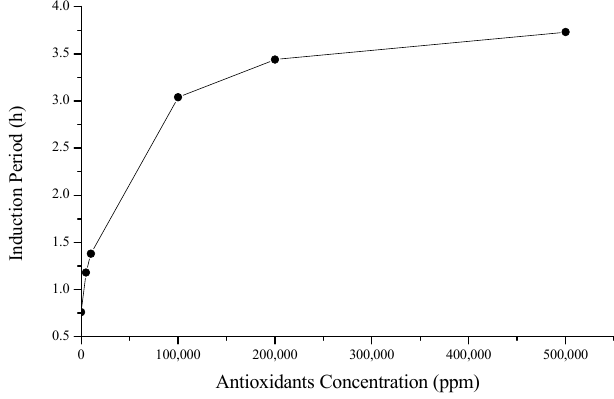
Figure 9. Effect of concentration of CNSL in induction period of methyl biosiedel of B. glabra . Table 3. Induction periods obtained to the methyl biodiesel of B. glabra (MBBg) doped TBHQ, BHT or LCC CNSL at different concentrations.